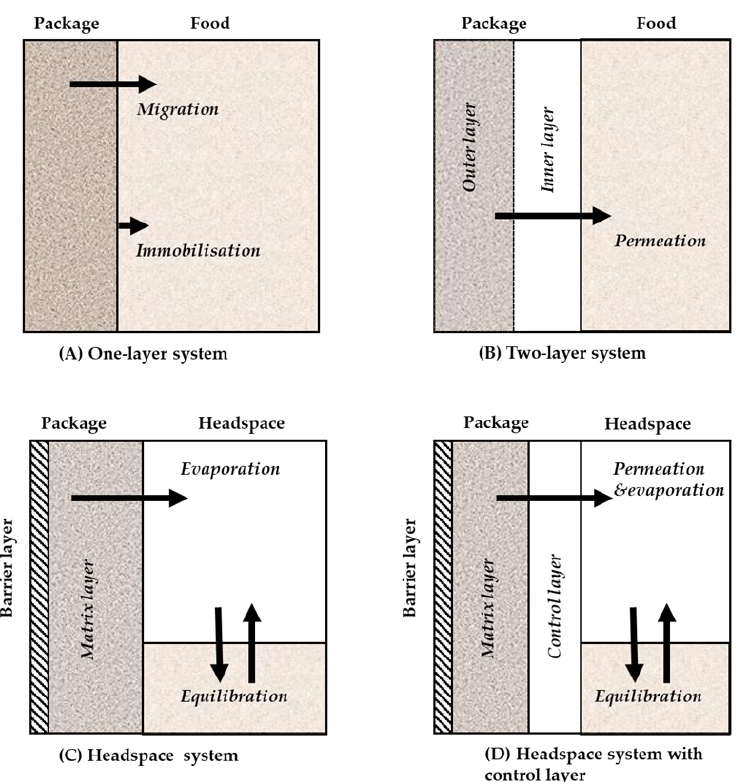
Figure 2. Antimicrobial packaging system (adapted from Jideani and Vogt (2016) [22] and Han (2003) [91]). In Figures 2A,B, antimicrobial agents are released through diffusion between the packaging material and the food and partitioning at the interface. The inclusion of the antimicrobial agent into the packaging material is chemically bonded via immobilization (Figure 2A). In Figure 2A, the antimicrobial agent is incorporated into the packaging ma- terial. To regulate the release rate, particularly in the two-layer system (Figure 2B), the antimicrobial agent (outer layer) is coated on the packaging material (inner layer), or the antimicrobial matrix layer (outer layer) is laminated with the control layer (inner layer). Figure 2C depicts a headspace system. Here, the volatile antimicrobial agent initially in- tegrated into the matrix layer is released into the headspace. Equilibrated sorption/iso- therm is used to partition the headspace antimicrobial agent from the food product. A headspace system with a control layer is shown in Figure 2D. The control layer precisely regulates the permeability of the volatile antimicrobial agent and maintains a specific headspace concentration [91,92]. Figure 2C,D show that the antimicrobial agent ’ s volatil- ity permits it to reach the gaseous-phase particle ’ s headspace to contact the food product.